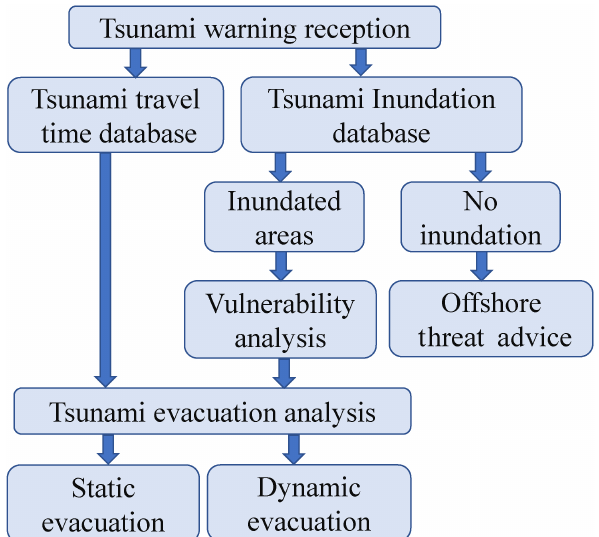
Figure 1. Framework of the decision support system.